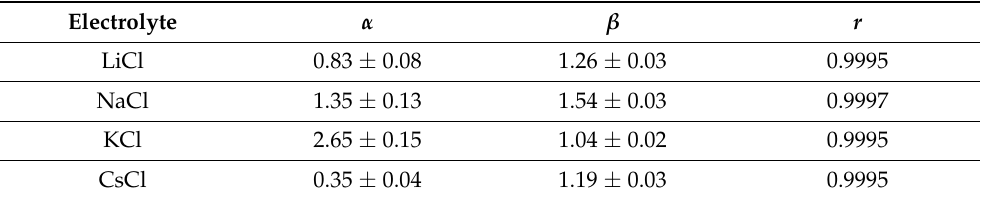
Table 4. Parameters α (10 − 5 Am − 2 K − β ) and β , and regression coefficient r (from fitting the experi- mental data in Figure 6 to Equation (7)) for the different